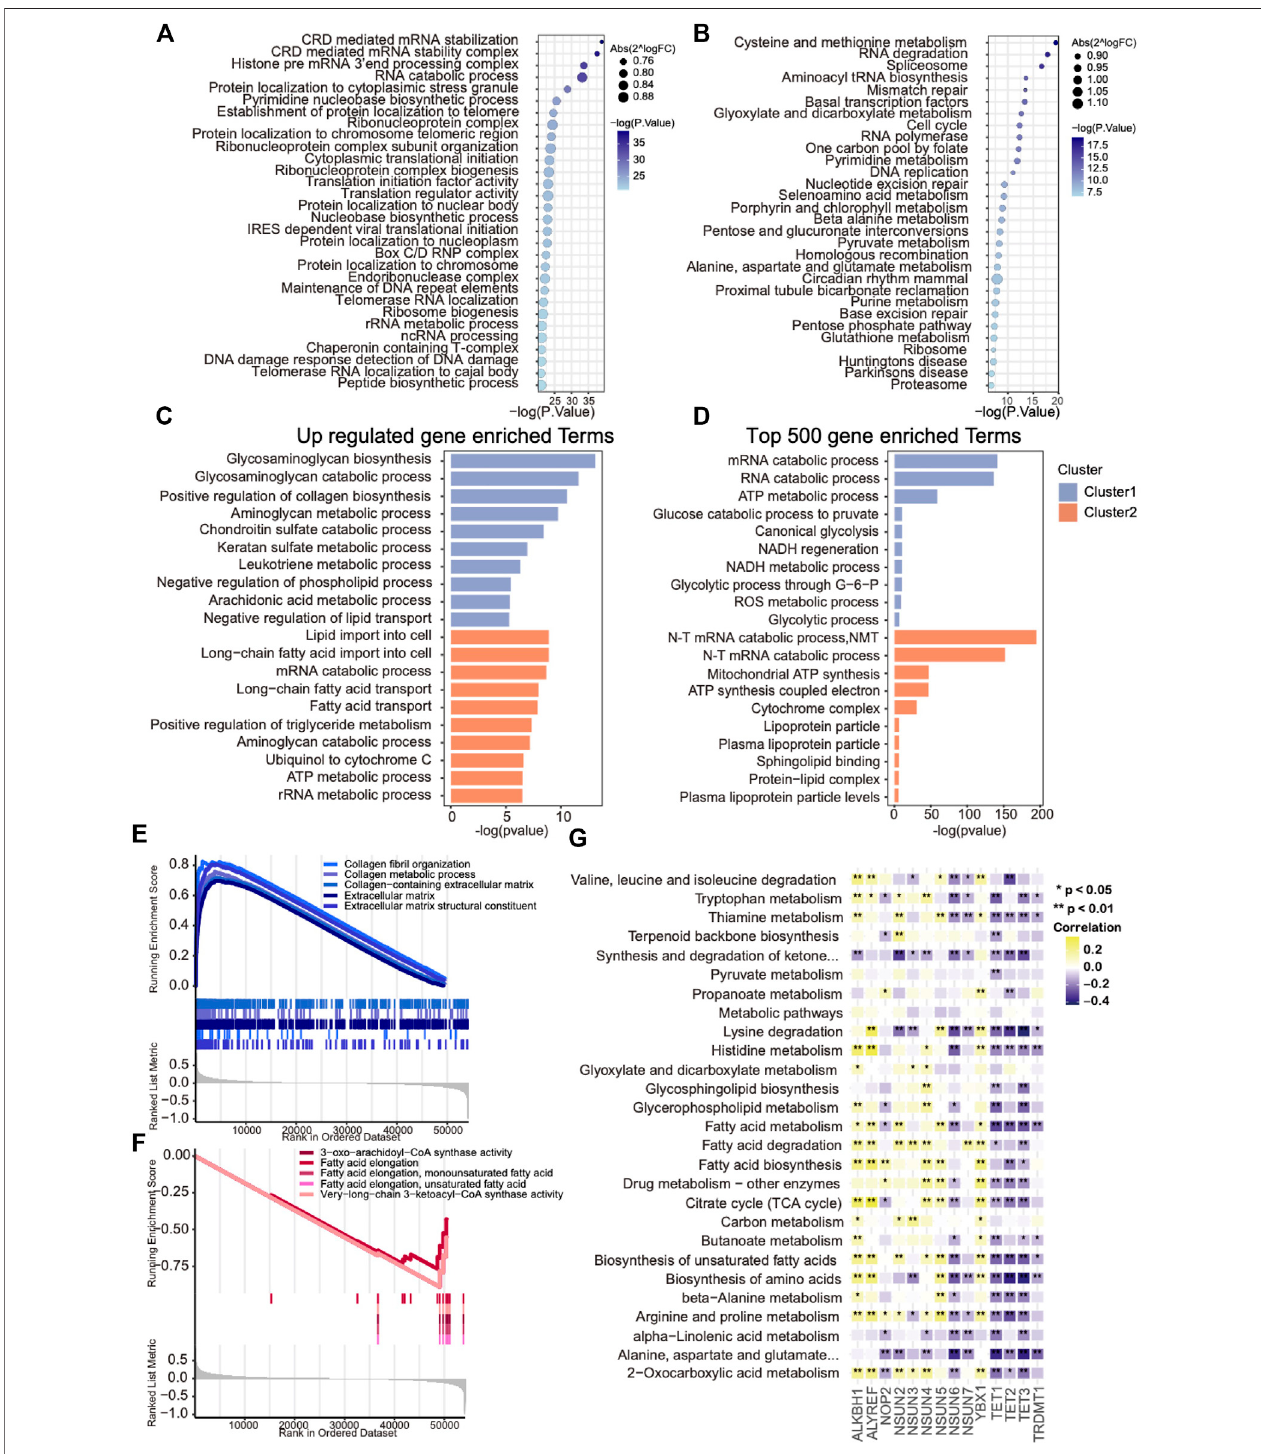
FIGURE4| Metabolicheterogeneityinovariancancerswithdistinctm 5 Cmodi fi cationpatterns. (A,B) BubbleplotshowingGSVAenrichmentanalysisofthetop30 changed GOandKEGG hallmark pathwaysbetweentwom 5 Cclusters. (C) Themost enriched metabolism-related GOpathways using differentially expressed genesin eachm 5 Ccluster. (D) Themostenrichedmetabolism-relatedGOpathwaysusingthetop500up-regulatedgenesineachm 5 Ccluster. (E,F) GSEAanalysisshowingthe signi fi cantmetabolism-relatedpathwaysup-regulatedineachm 5 Ccluster. (G) CorrelationanalysisbetweenGSVAenrichmentscoresofthechangedmetabolism- related pathways in each m 5 C cluster and mRNA levels of m 5 C regulators.